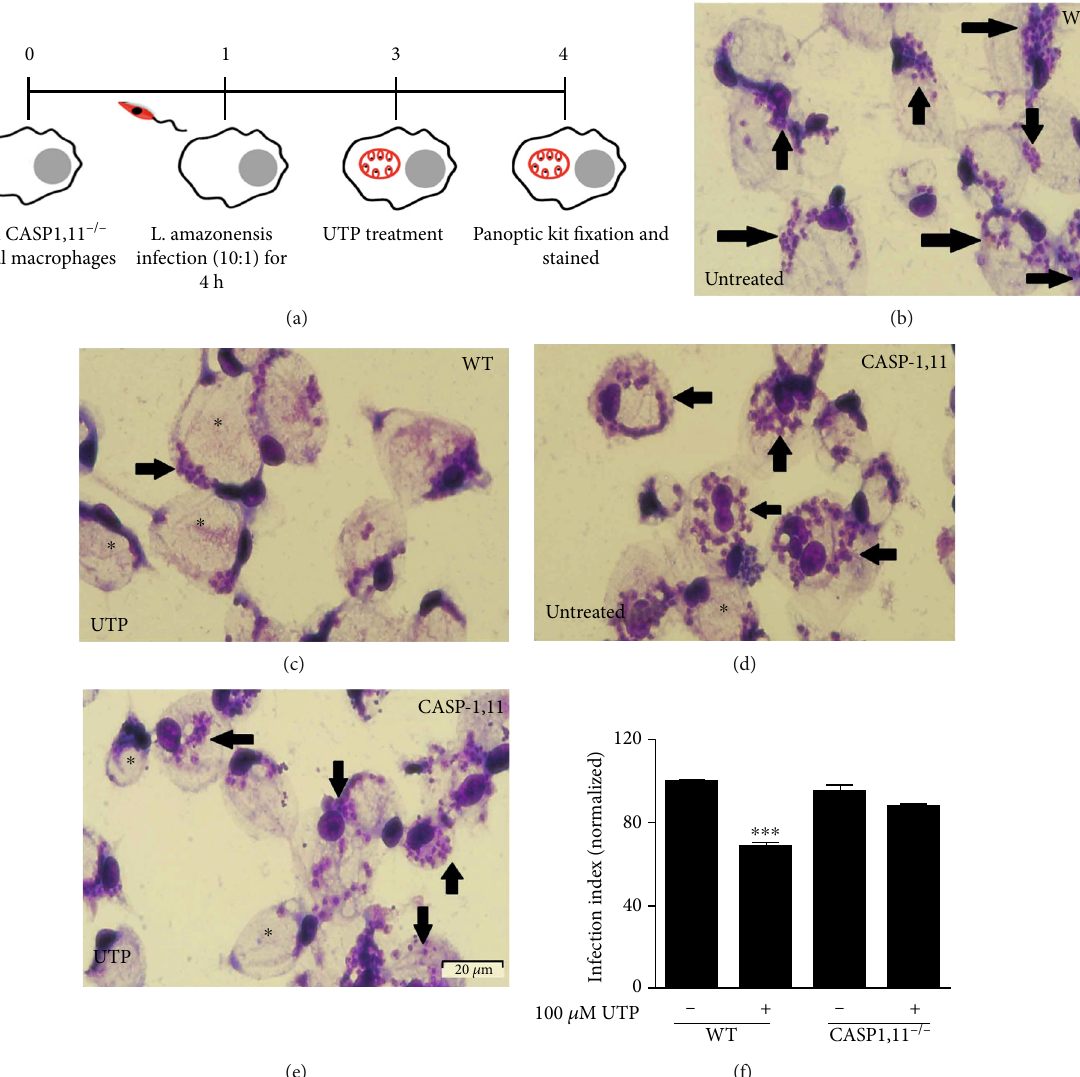
Figure 2: Control of L. amazonensis infection by UTP requires CASP-1,11. (a) Schematics showing the infection and treatments. Representative images of infected peritoneal macrophages from WT (b, c) and CASP-1,11 -/- (d, e) treated with UTP (100 μ M) (d, e) for 30min or left untreated (b, c). The antiparasitic e ff ect of UTP treatment was evaluated through the “ infection index ” (f). Data represent mean ± SEM of three independent experiments performed in triplicate, with pools of 3 – 4 animals in each experiment. ∗∗∗ P < 0 : 0001 relative to the untreated group (one-way analysis of variance followed by Tukey ’ s